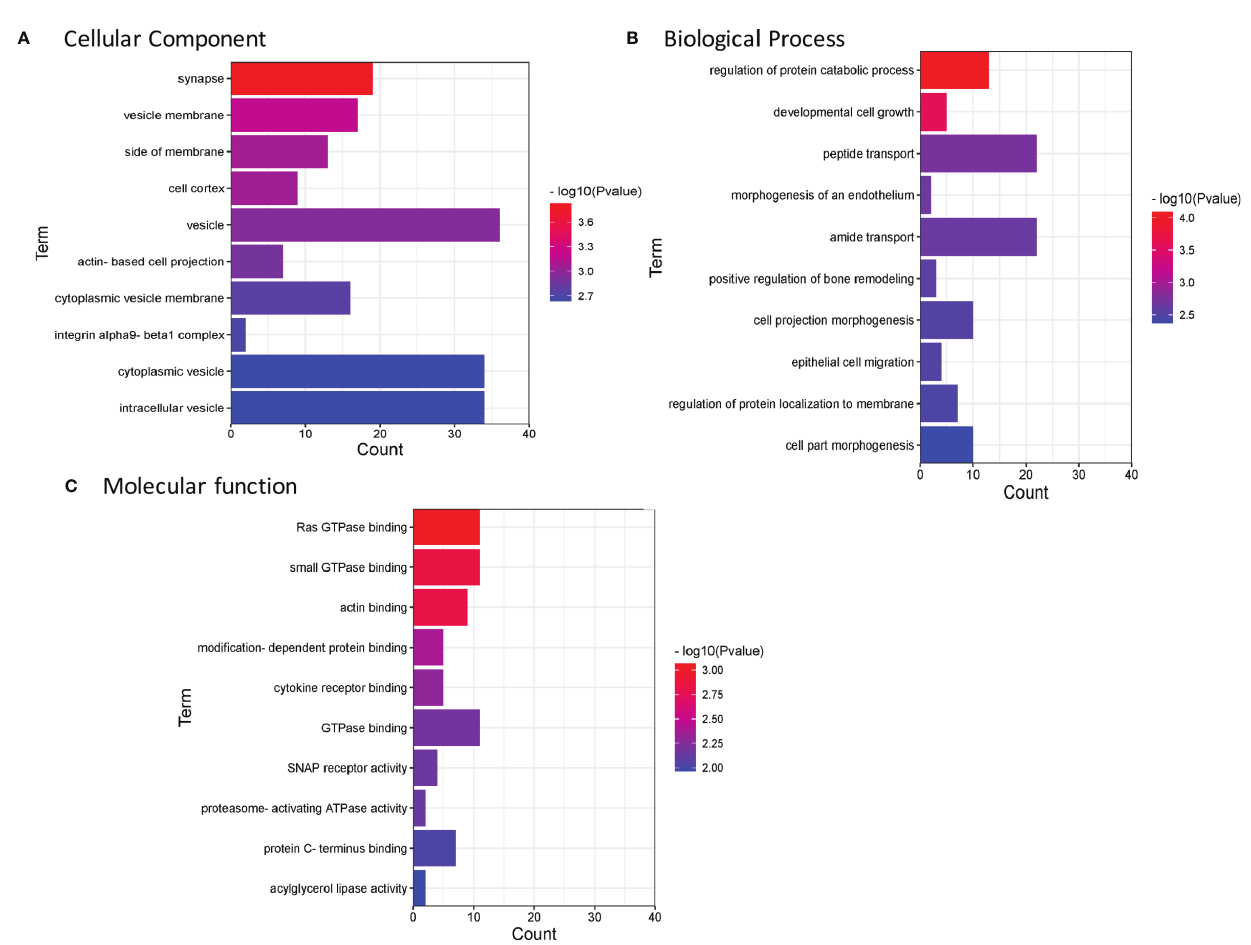
FIGURE 4 | Enrichment analysis of GO annotations in identi fi ed ubiquitinated proteins (top 10). (A) Cell component. (B) Biological process. (C) Molecular function. GO, Gene